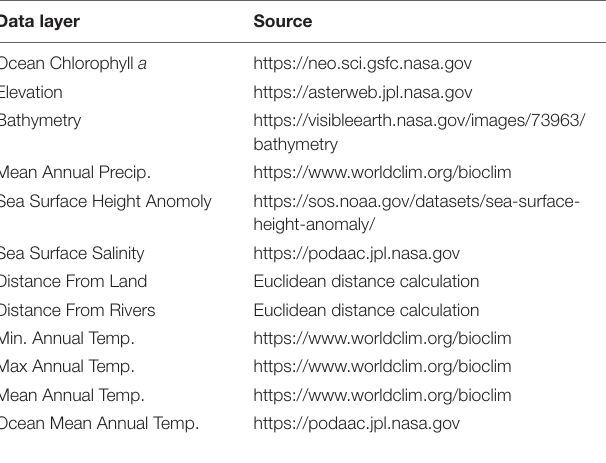
TABLE 1 | Data sources for the predictor variables used in the Random Forest